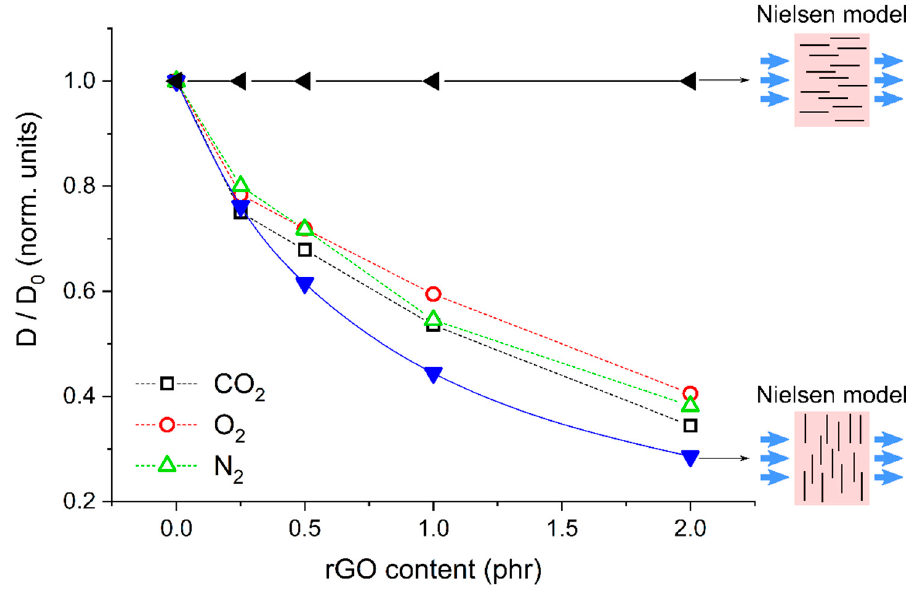
Figure 11. Comparison between the experimental D / D 0 values (open symbols) and those calculated through the Nielsen model in two opposite cases (solid symbols) for the samples PLA-PDoF10-rGOx (x = 0.25 ÷ 2 phr).